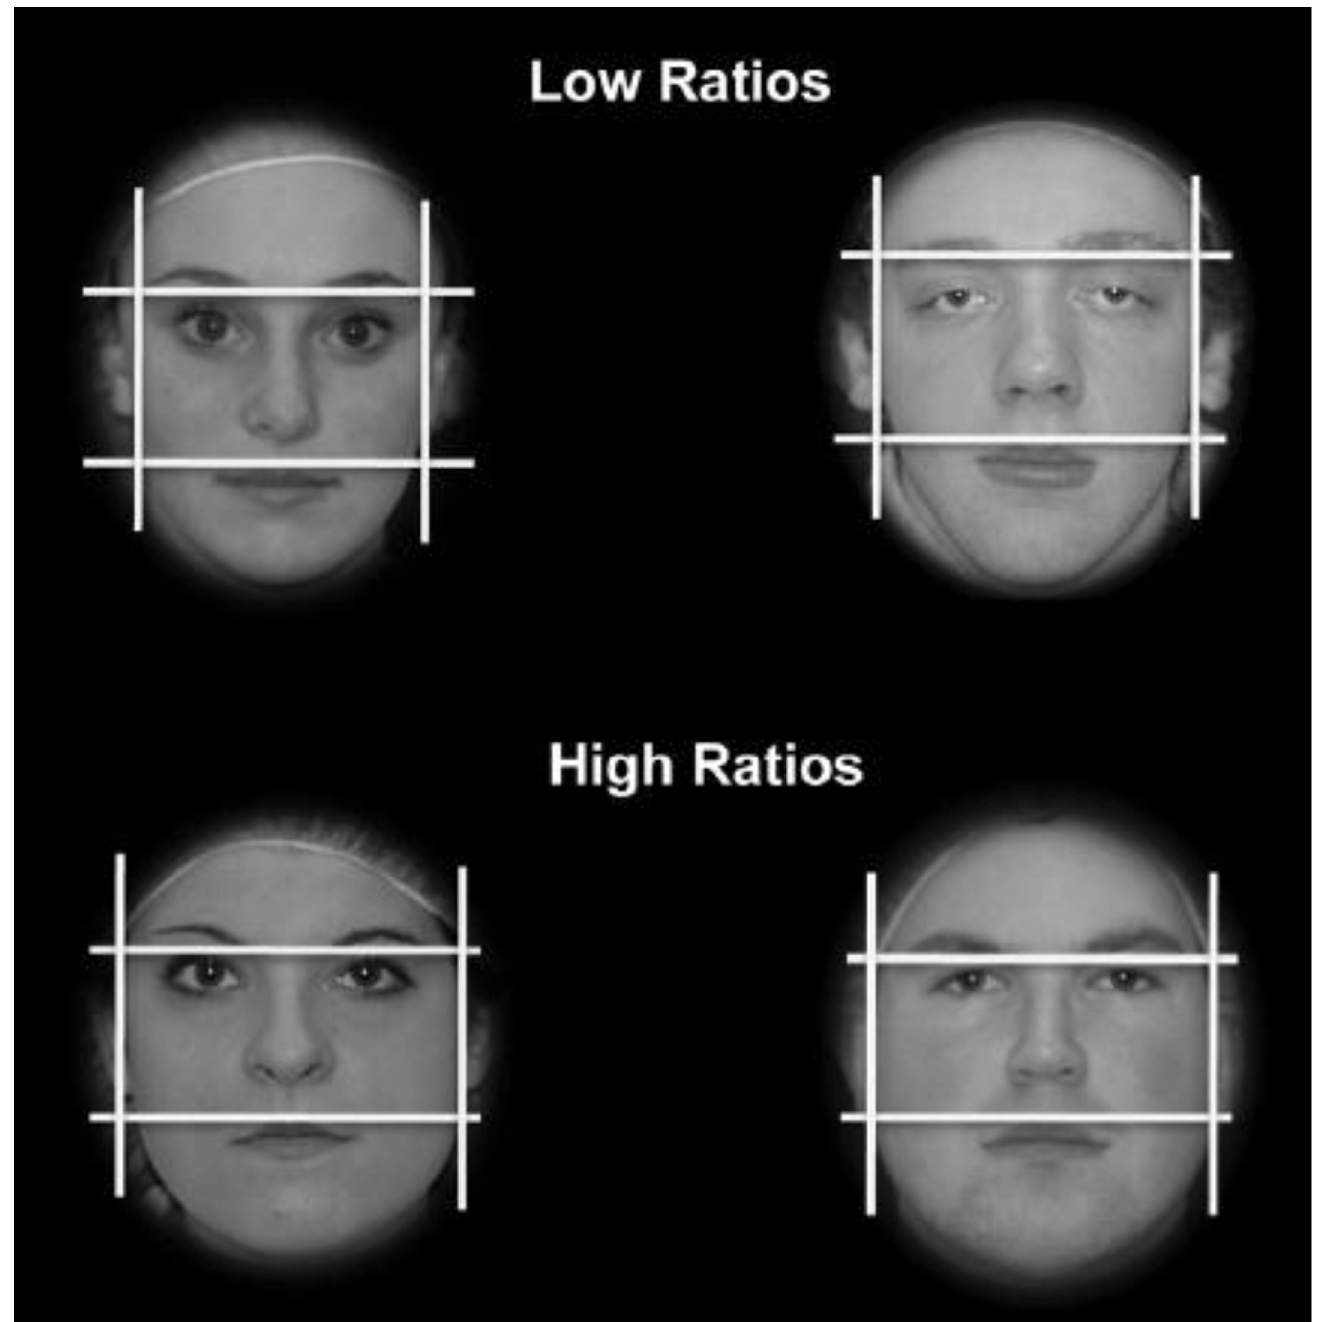
Fig 1. Examples of measurement of the FWHR in faces with relatively low and high